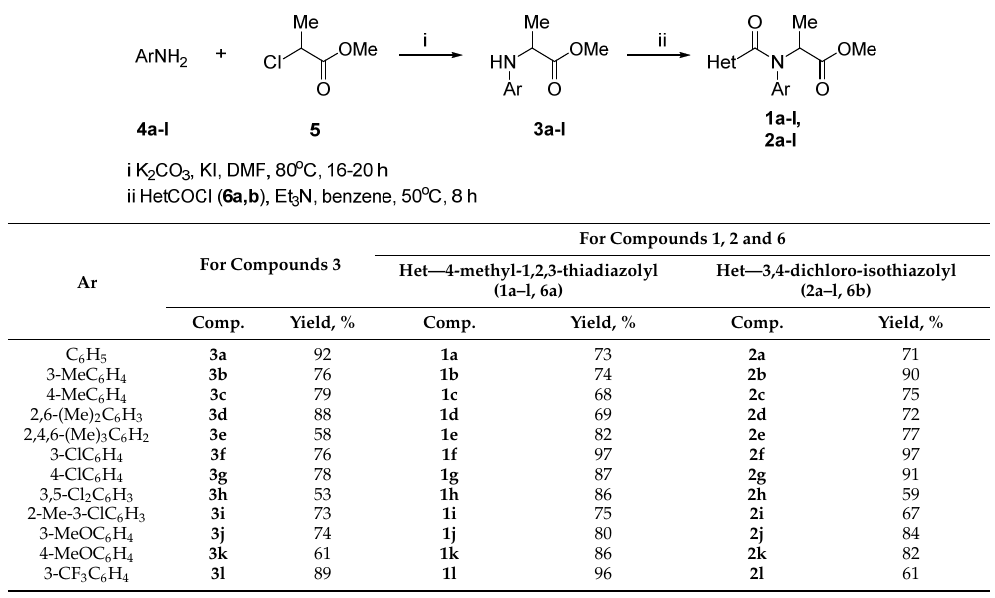
Table 2. Synthesis route of the target compounds 1a – l and 2a – l .